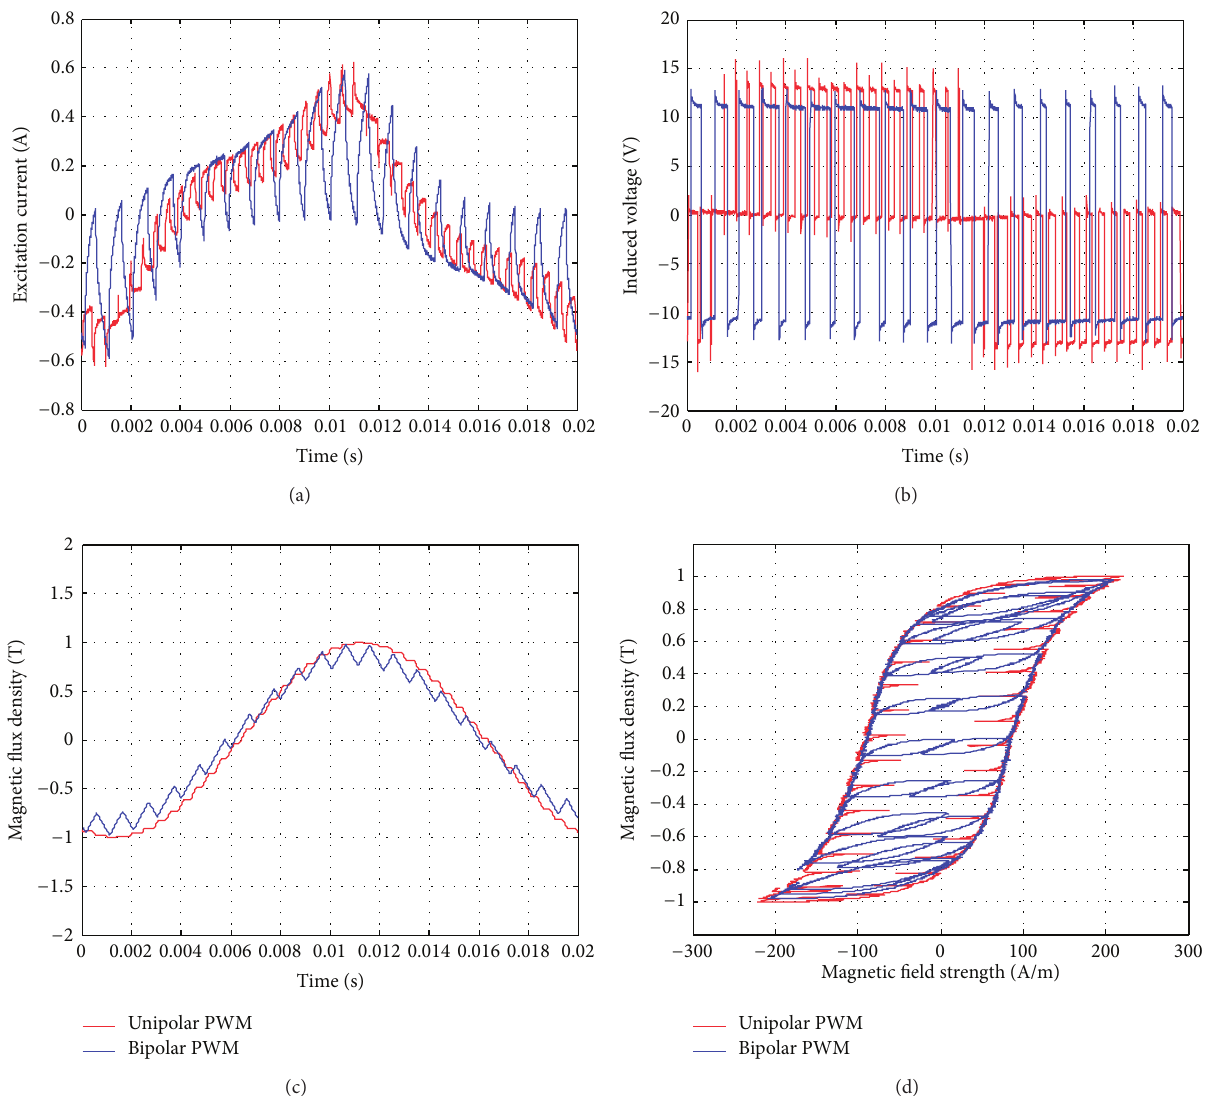
Figure 22: Parameters measured using the new toroidal frame for bipolar and unipolar PWM (with 𝐵 = 1T, 𝑓 = 50 Hz, 𝑚 𝑎 = 0.6 , and = 20 ): (a) excitation current, (b) induced voltage, (c) flux density, and (d) hysteresis 𝑚 𝑓